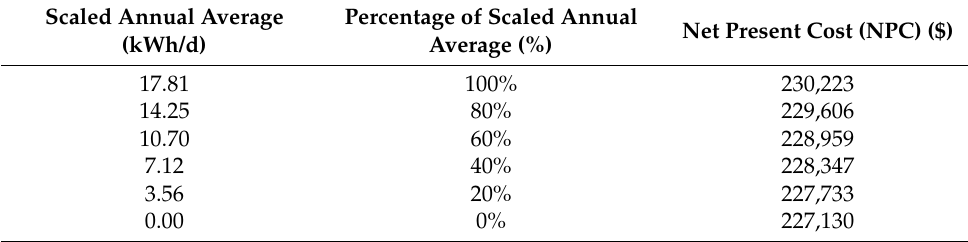
Table 5. Sensitivity analysis on scaled annual average of thermal